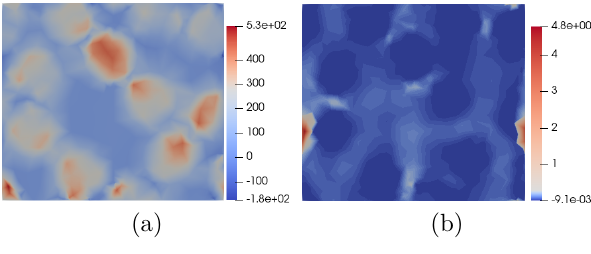
Figure 13. Basalt composite with maximal stiffness, time = 50 s: a) Shear stress [MPa], b) creep strain.